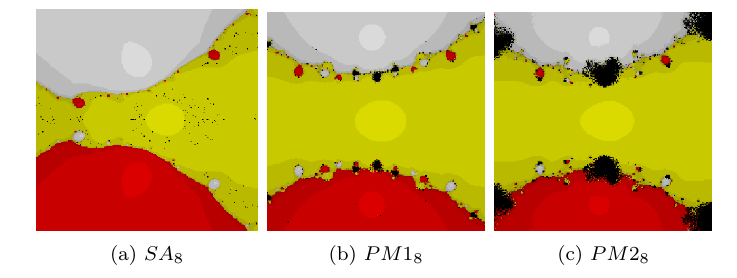
Figure 4. The methods for test problem 2.